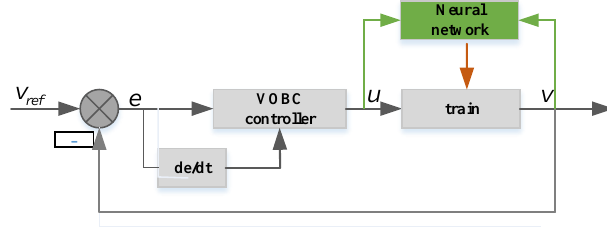
Figure 3. Train model online learning structure diagram.